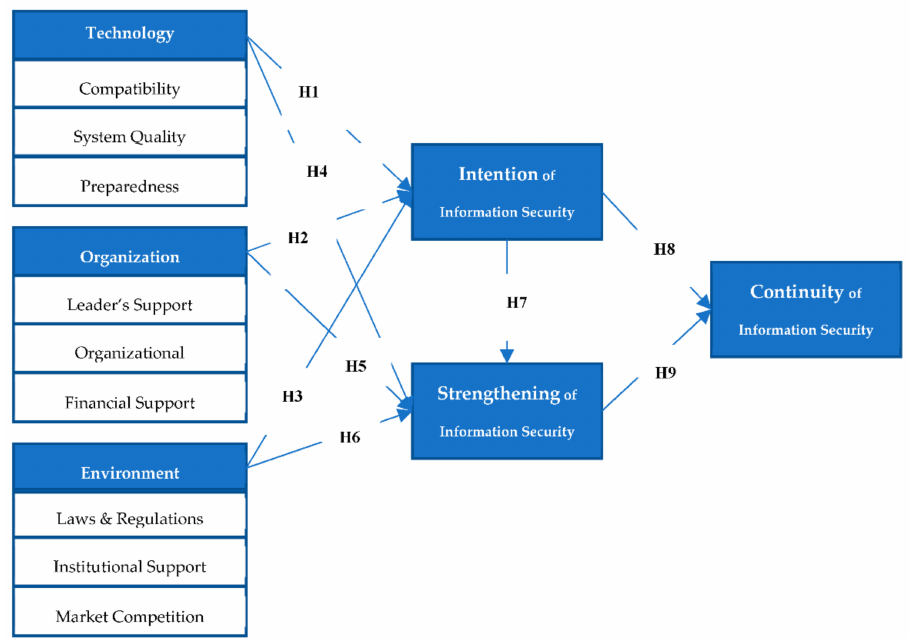
Figure 1. Research